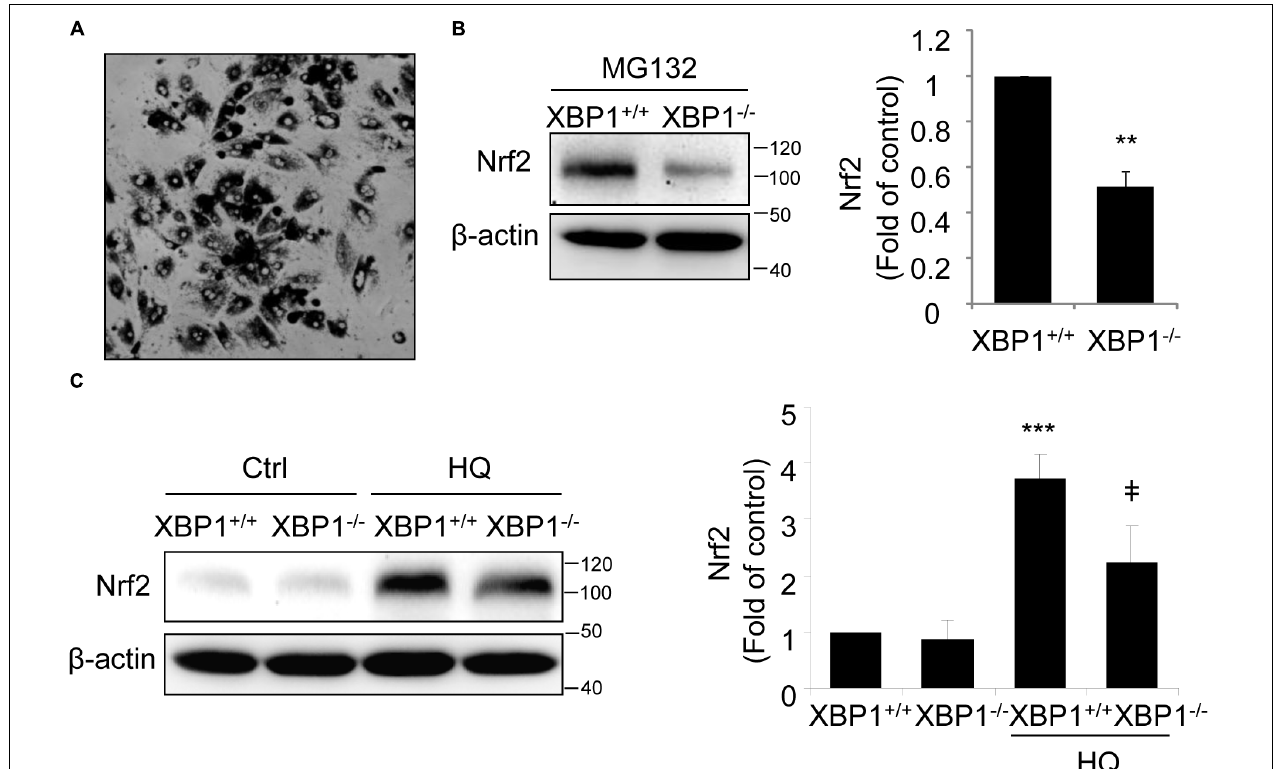
FIGURE 2 | Impaired Nrf2 activation in primary RPE cells isolated from XBP1 KO mice. Primary RPE cells were isolated from WT and KO mice and cultured in a 12-well plate until confluence. (A) Phase contrast image of isolated RPE cells. (B) After proteasome inhibitor MG132 treatment (10 µ M, 30 min), Nrf2 expression in primary RPE cells was detected by Western blot and semi-quantified by densitometry ( n = 3 independent isolations, ∗∗ p < 0.01). (C) Primary RPE cells were treated with a potent pro-oxidant, hydroquinone (HQ) (100 µ M, 6 h), and Nrf2 expression was detected by Western blot ( n = 3 independent isolations; ∗∗∗ p < 0.001 vs. XBP1 + / + untreated control, ‡ p < 0.05 vs. XBP1 + / + cells treated with